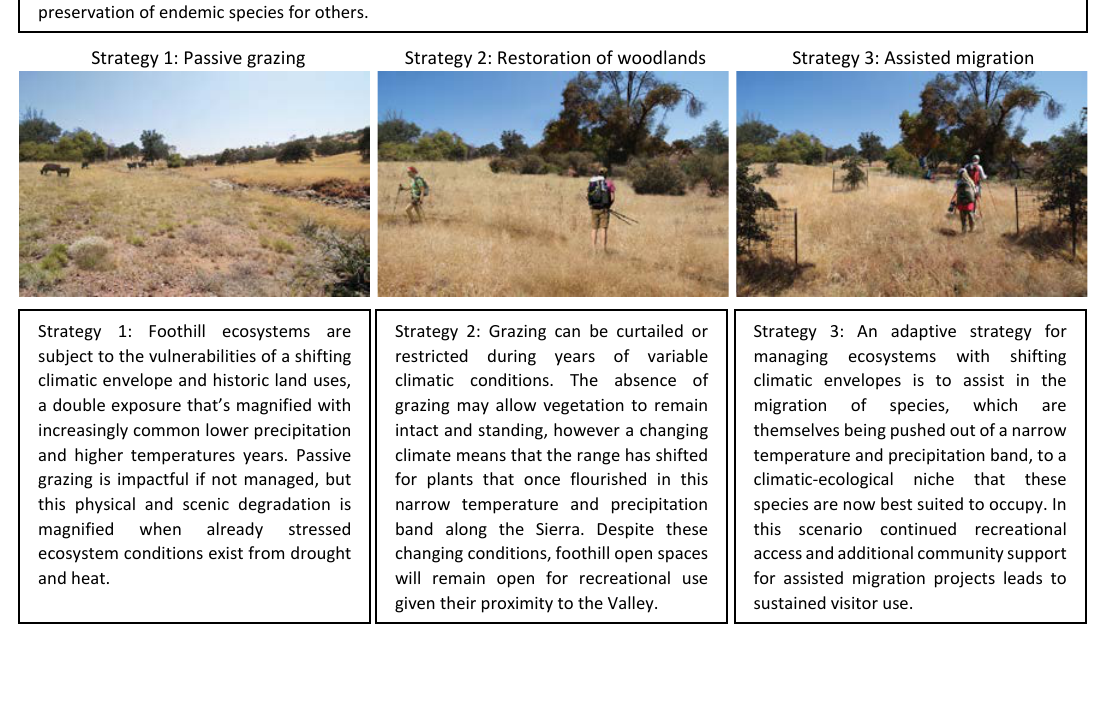
Fig. A1.11 - Site 11: Highway 190 near Camp Nelson